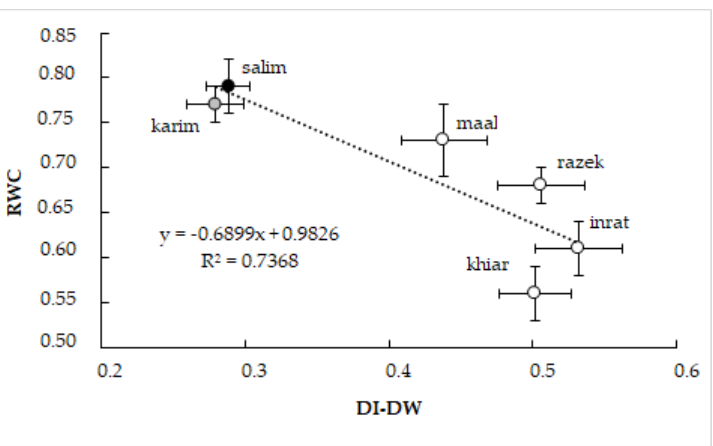
Figure 8. Relationship between relative water content (RWC) and drought index based on dry weight (DI-DW) in durum wheat ( Triticum durum Desf.) genotypes subjected to drought stress. Vertical standard errors of means of 10 replicates; horizontal standard errors of means of 30 replicates.